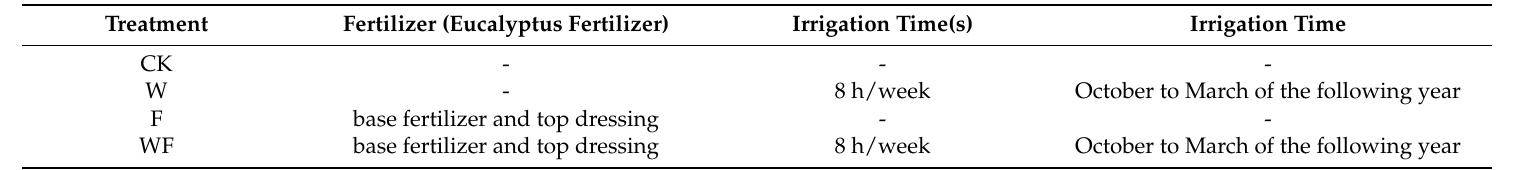
Table 1. The four combined treatments. Supplemental irrigation and fertilizer addition was as follows: CK, no irrigation or fertilizer; W—irrigation only; F—fertilizer only; WF—irrigation and fertilizer.